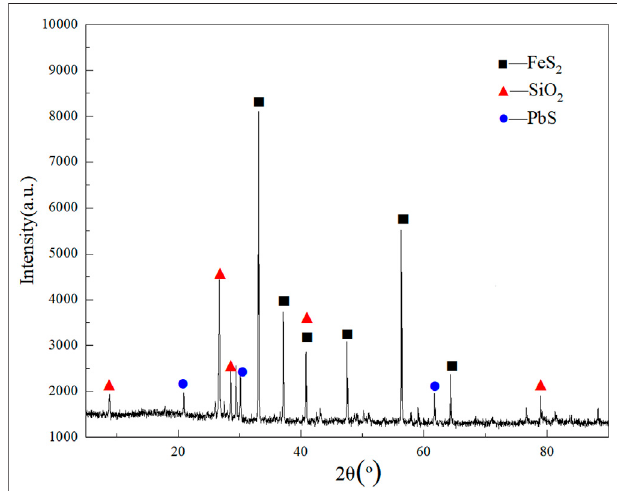
FIGURE 9 | XRD diffractograms of optimum experiment leaching residue.